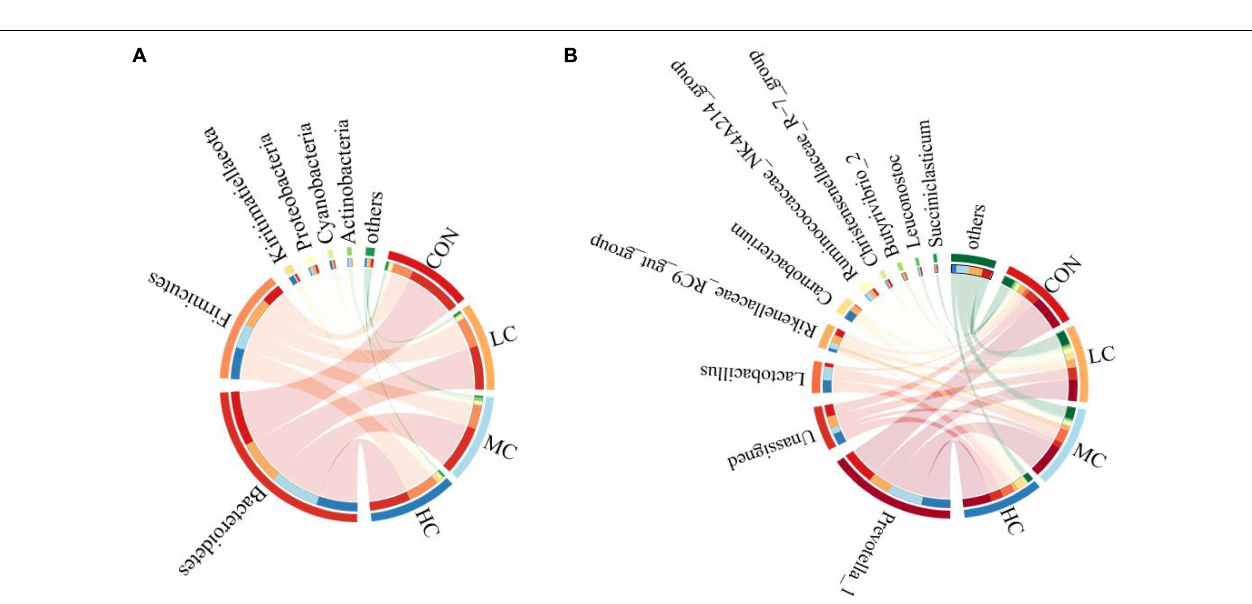
FIGURE 6 | Bacterial phyla (A) and genus (B) (relative abundance > 1%) of 4 treatments visualized using Circos.